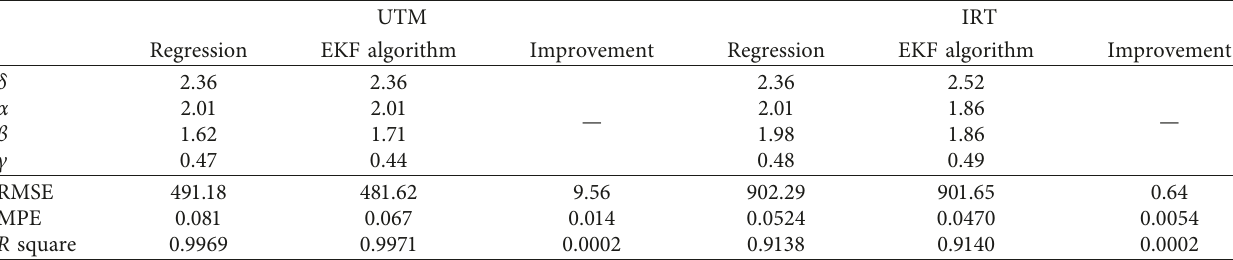
Figure 10: Master curves using the EKF Table 4: Improvement of EKF algorithm.